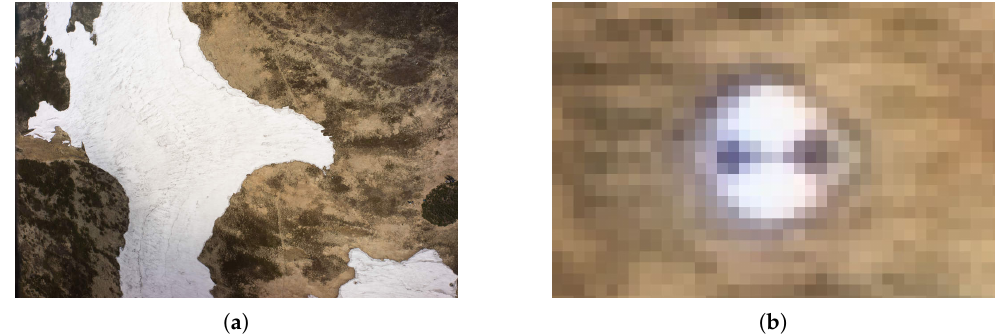
Figure 10. A photo captured from the height of 100 m AGL ( a ); a zoomed ground target ( b